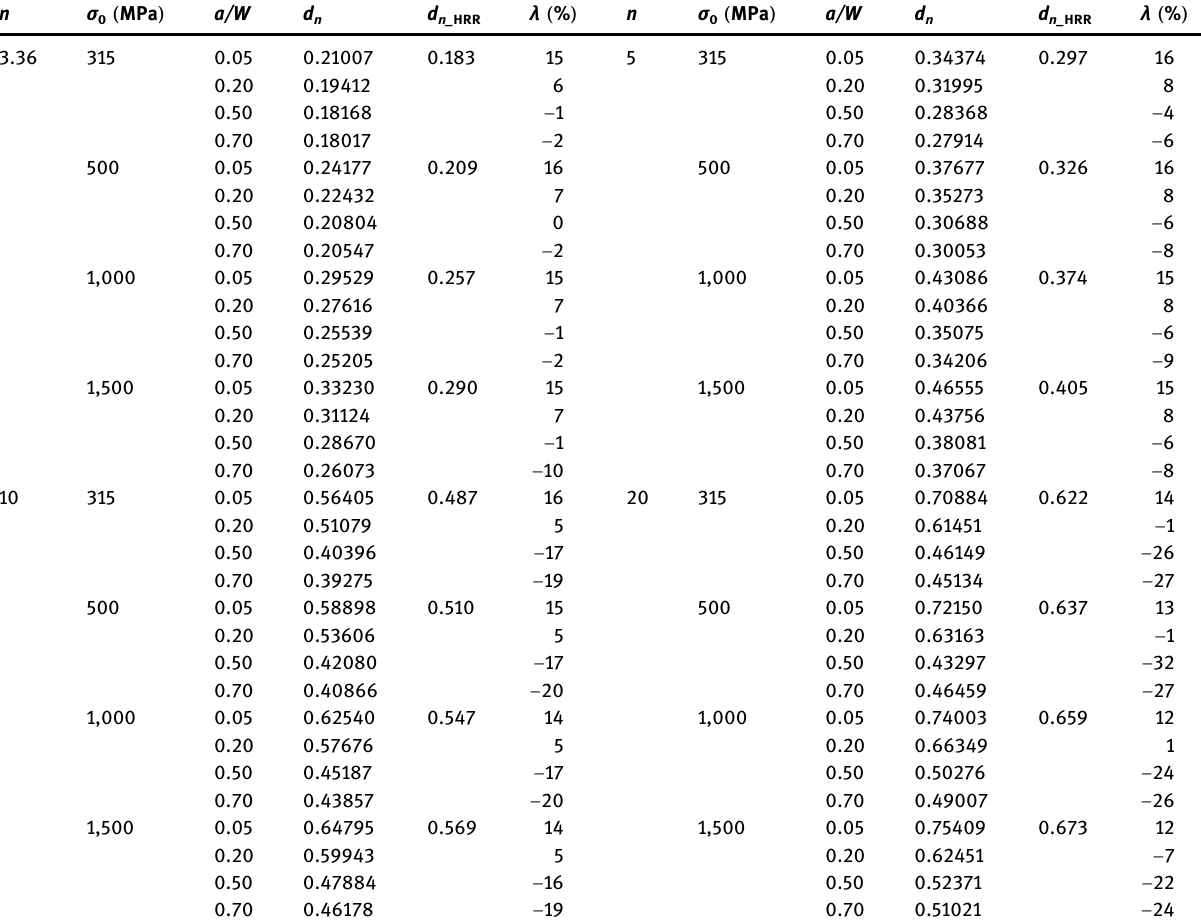
Table 6: Values of the d n coe ffi cient determined for the SEN ( 4PB ) specimens based on the performed numerical calculations with a comparison with the value of the d n_ HRR coe ffi cient determined on the basis of the HRR fi eld parameters according to the algorithm presented in ref. [ 17